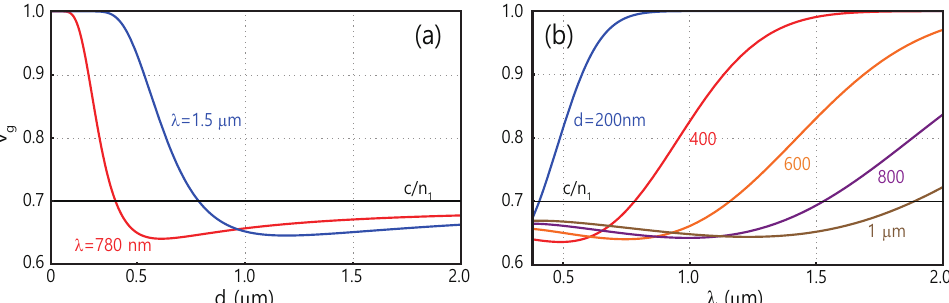
Figure 12. Group velocity of the fundamental modes ( a ) as a function of diameter at λ = 780 nm and λ = 1.5 µ m, ( b ) as a function of wavelength at different diameters.